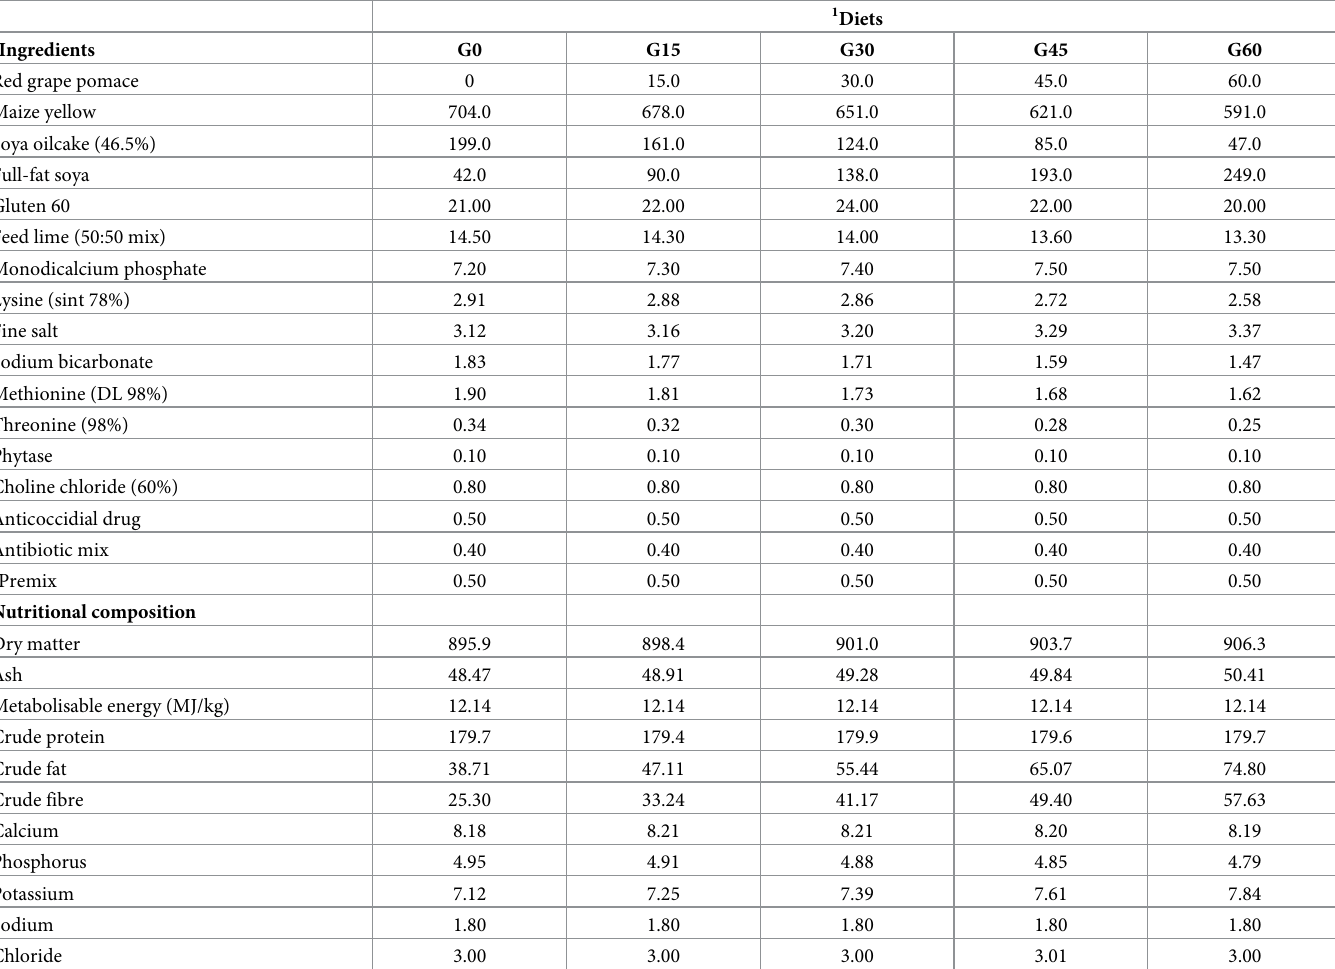
Table 1. Gross ingredient and chemical composition (g/kg as fed , unless stated otherwise) of experimental